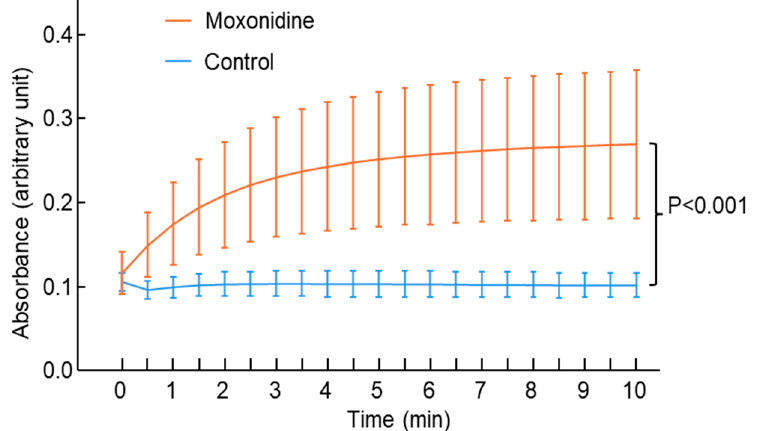
Figure 7. Effect of moxonidine administration on plasma lipid peroxide levels. Mice were treated with moxonidine (18 mg/kg body weight/day) via drinking water until the end of the experiment, while the control mice received normal drinking water only. Three days after the initiation of moxonidine administration, angiotensin II was subcutaneously infused into all the mice for 28 days to induce atherosclerosis. Mice were culled at the end of the angiotensin II infusion and plasma was collected. Lipid peroxide levels in the plasma were measured every 30 s. Higher absorbance = higher lipid peroxide levels. The difference in plasma lipid peroxide levels between the two groups was analysed using multiple linear regression: dependent variable = absorbance and independent variables = groups and time. Data represent mean ± standard error; N = 5 per group.